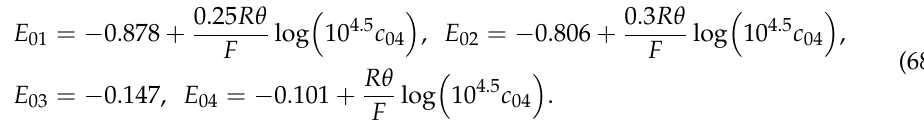
Table 1. Physical parameters used in [8], valid for pH = 4.5 and the concentration of H 2 PO −